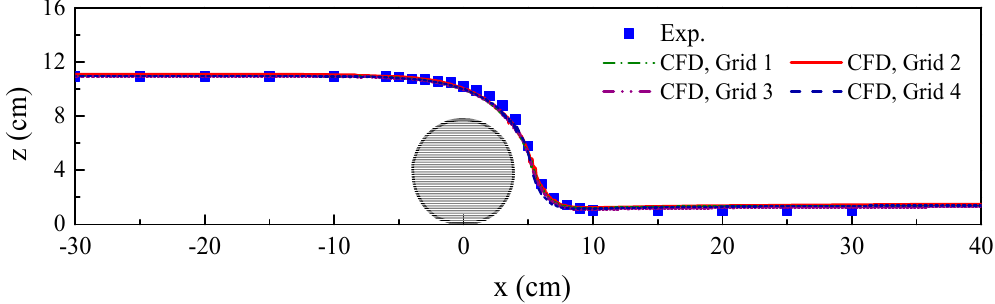
Figure 4. Comparison of measured and simulated water surfaces by different computational grids for the validation case (Case A1). Table 1. Simulation results of the validation case by different computational grids.